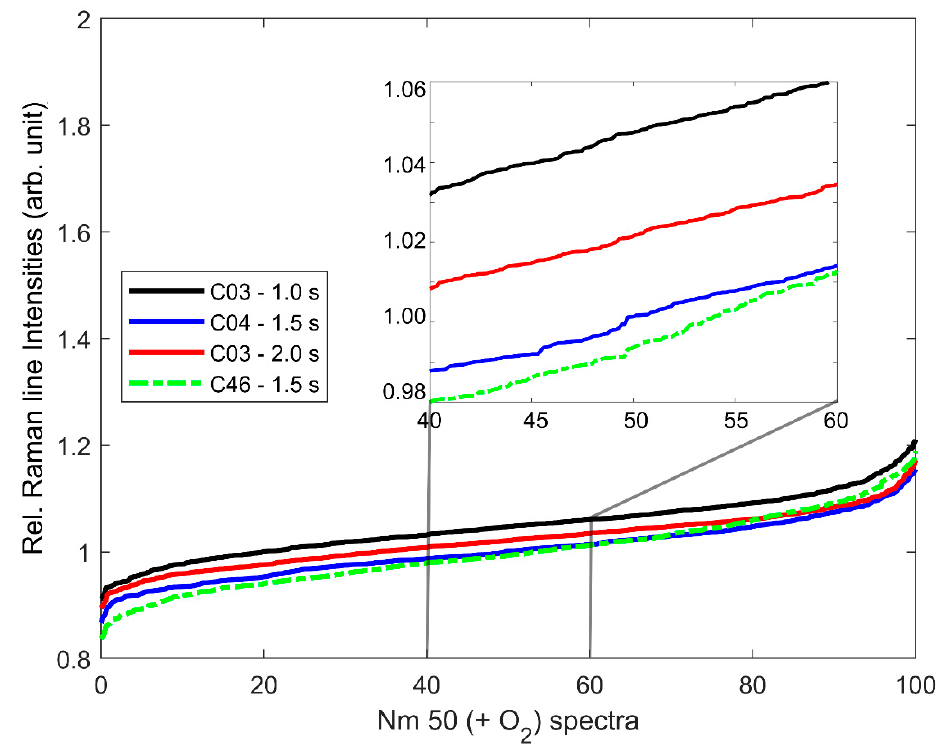
Figure 2. relRI sorted in ascending order of 100 random cells each from four different batches of Nm 50 grown non-simultaneously from two different stock cultures (C03, C46) under optimal growth conditions. The underlying Raman spectra were recorded with three different excitation times (1.0 s, 1.5 s, 2.0 s).